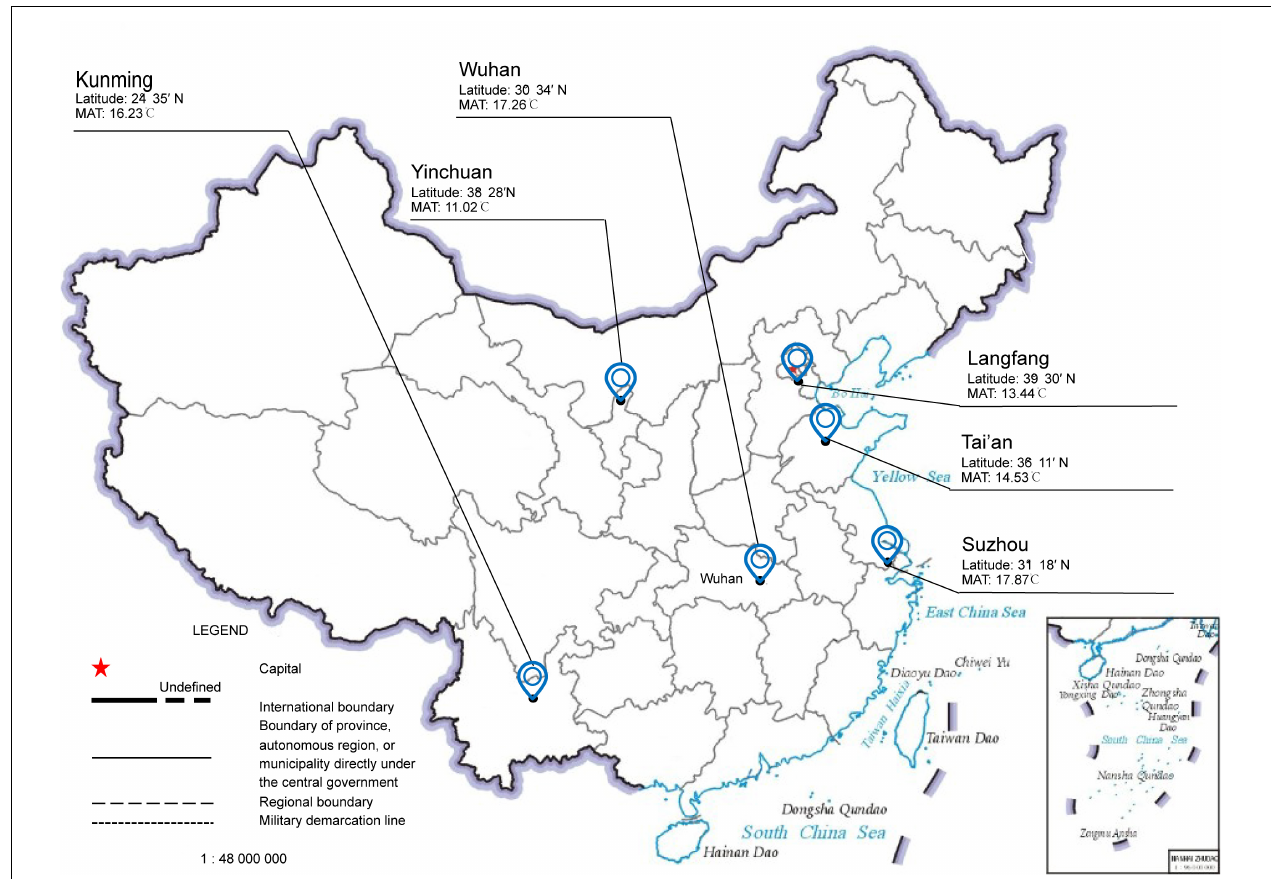
FIGURE 1 | Map of China showing the locations of the sampling sites and the mean annual temperature (MAT) were calculated on 2015 and 2018